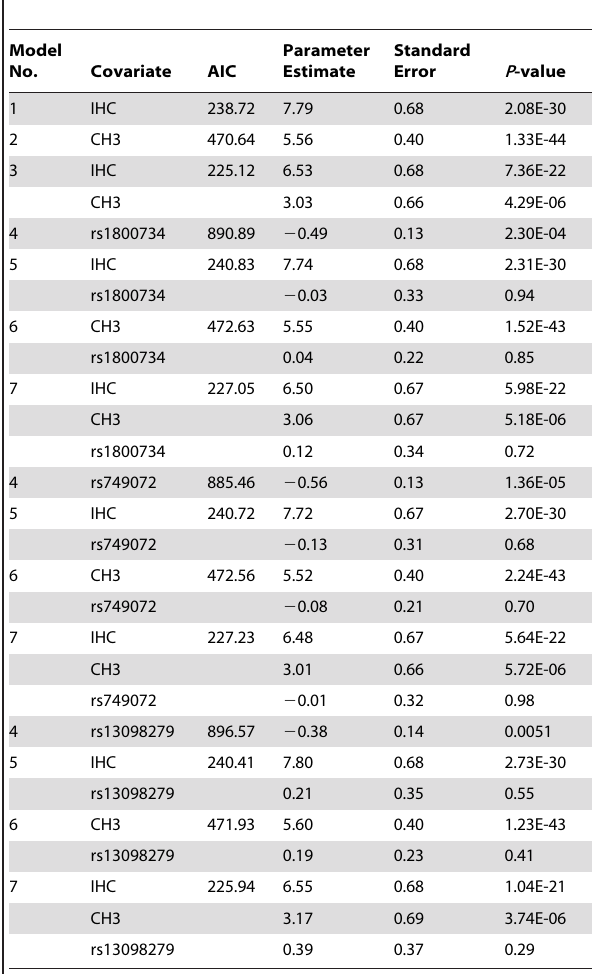
Table 3. Logistic regression model results for MSI status with various predictor combinations in the combined data.